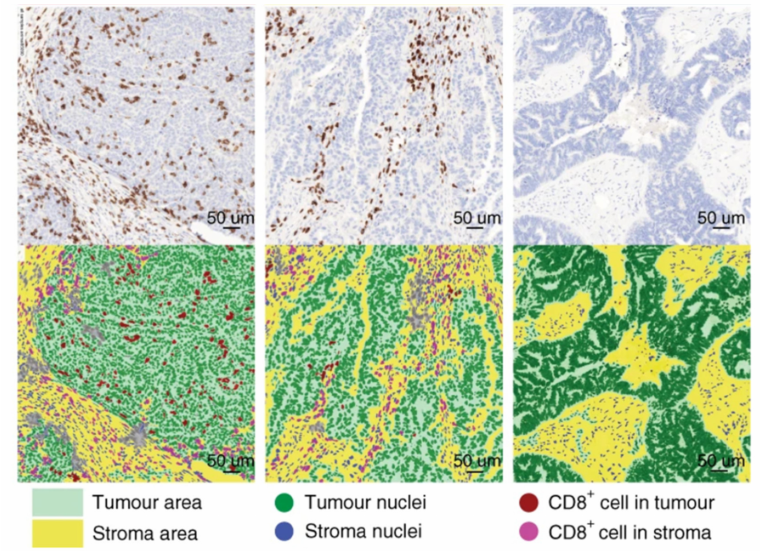
Figure 3. Analysis of the tumor immune microenvironment using next-generation digital